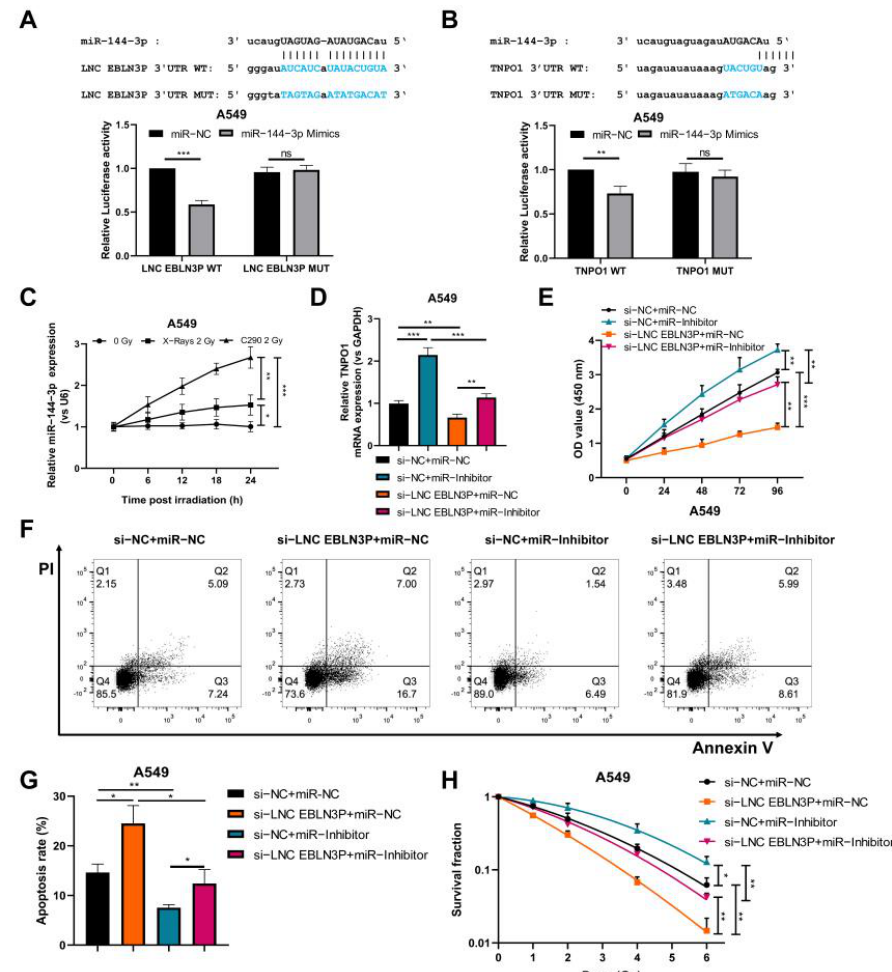
Figure 5. The regulation of LNC EBLN3P on TNPO1 is mediated by miR − 144 − 3p. ( A ) A schematic diagram of the interaction sites between LNC EBLN3P and miR − 144 − 3p. The relative luciferase activity of A549 cells was examined after co − transfection of LNC EBLN3P wild − type (WT) or mutant (MUT) luciferase reporter plasmids and miR − 144 − 3p mimic or negative control (miR − NC). ( B ) The interaction between miR − 144 − 3p and TNPO1 was examined by luciferase reporter assay. ( C ) The expression of miR − 144 − 3p was upregulated over time in A549 cells irradiated with X − rays or carbon ions. ( D – H ) A549 cells were co − transfected with si − LNC EBLN3P or negative control (si − NC) and miR − 144 − 3p inhibitor (miR − inhibitor) or negative control (miR − NC), and TNPO1 mRNA expression, cell viability, apoptosis, and radiosensitivity were examined. Data shown in ( A – H ) represent the mean ± SD ( n = 3). * p < 0.05, ** p < 0.01, *** p < 0.001.